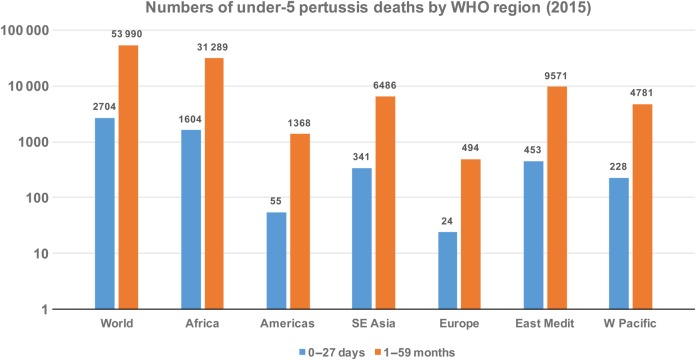
Under-5 pertussis deaths in the different World Health Organization (WHO) regions in 2015, during and after the first month of life [33].